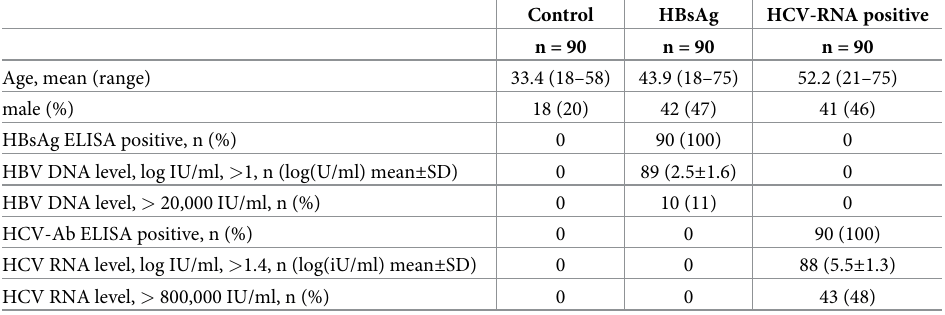
Table 2. Demographic and virological characteristics of the study population including the control group, HBsAg seropositive and HCV-RNA positive